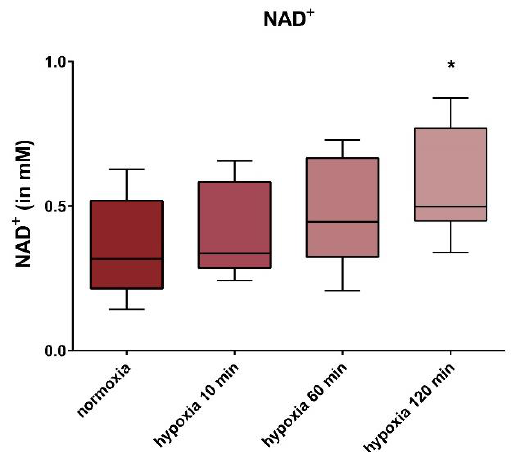
Figure 4. Intracellular NAD + concentration in the HUVECs. The normoxic controls were compared with the cells incubated under hypoxia for 10, 60, and 120 min. The NAD + concentration is presented in mM. Shown are the median, upper, and lower quartile, as well as the 5% and 95% percentile. Each group had a sample size of n = 3. Significance: * p < 0.05.